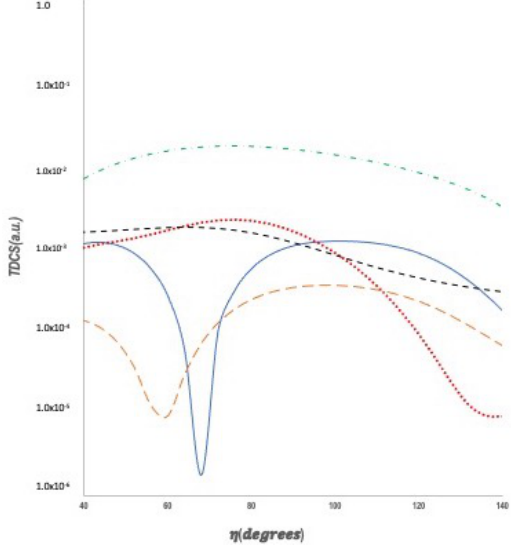
Figure 7. TDCS for the electron impact ionization of helium, E 0 = 64.6 eV, Φ = 67.5 ◦ comparison of different model calculations: 1st Born, as described in the text dotted black line; PWDWPW: purple dashed line; DWDWPW green dashed dotted line; DWBA solid blue